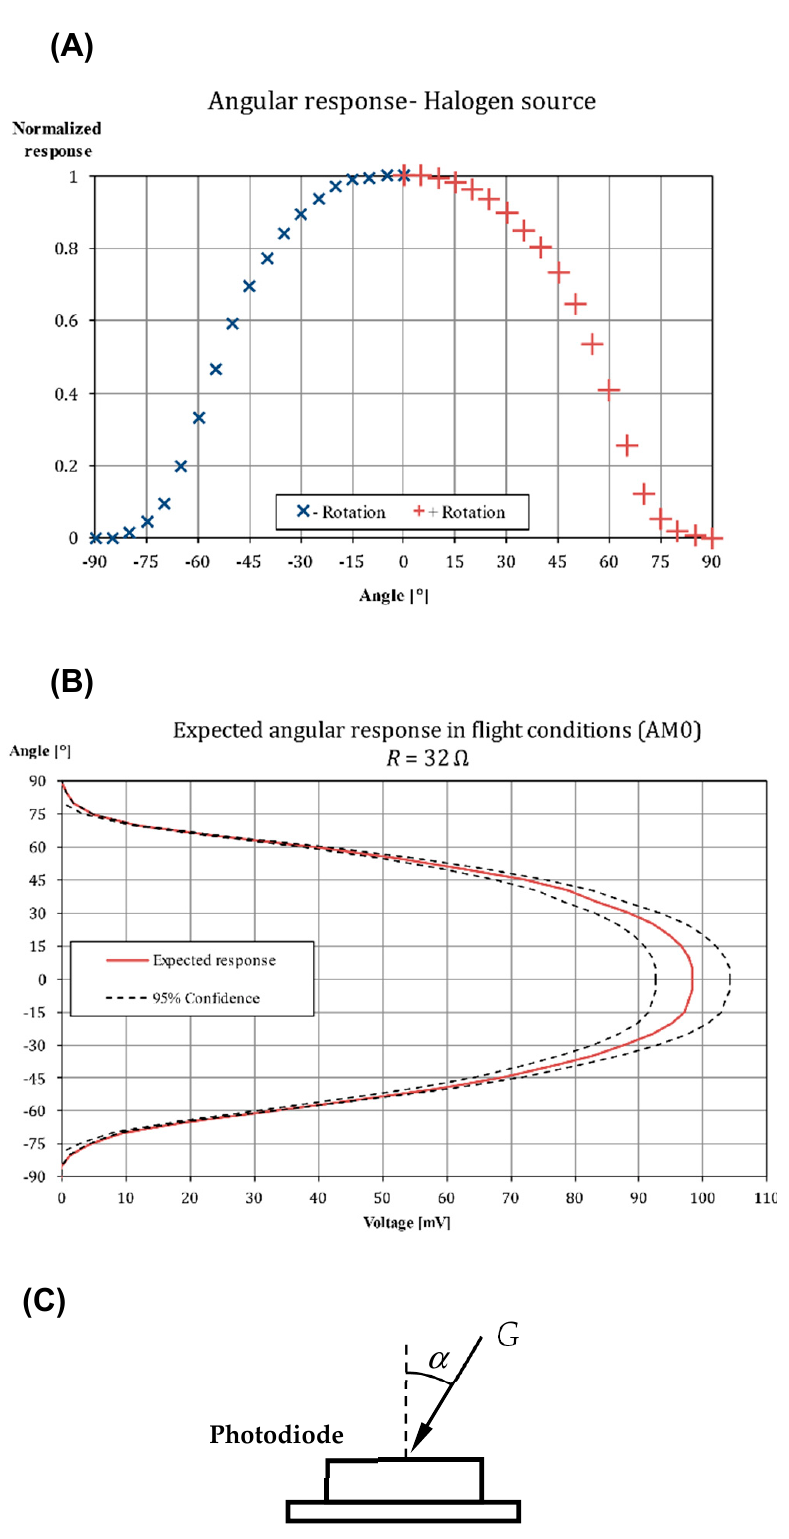
Figure 12. ( A ) Response of the photodiode SS1-X+ directional test. ( B ) Expected angular response of the photodiode SS1-X+ in AM0 spectrum. ( C ) Sketch of the photodiode under the irradiance, G , at angle α .